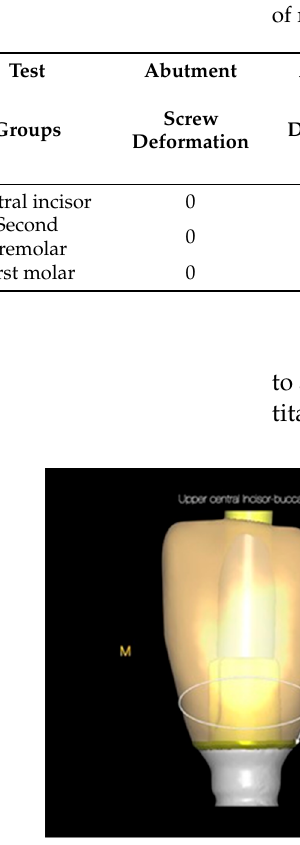
Figure 5. Three ‐ dimensional model of standardized abutments virtually sectioned horizontally at 3 mm above the implant platform. Front view.